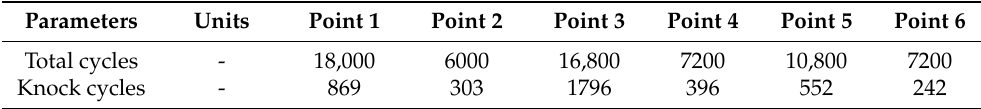
Table 6. The knock cycle determination results.